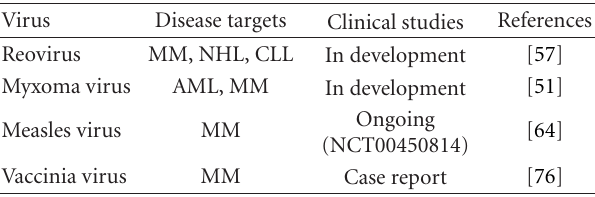
Table 1: Oncolytic viruses for the treatment of hematological